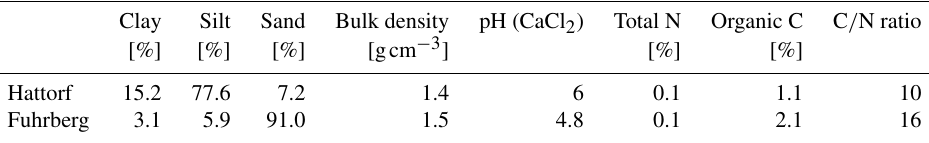
Table 1. Physical and chemical data of surface soil from Hattorf (silt-loam soil, 0 to 10cm depth) and Fuhrberg (sand, 5 to 20cm depth), Germany. Clay Silt Sand